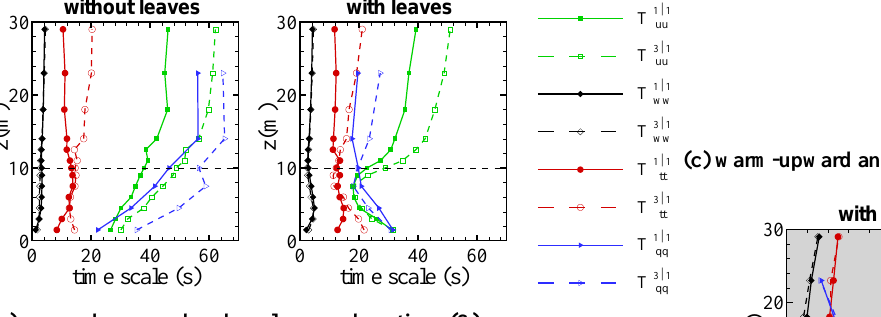
| 1 3 | 1 2 | 1 4 | 1 1 | 1 3 | 1 ϕϕ and T ϕϕ , (b) T ϕϕ and T ϕϕ and (c) T ϕϕ and T ϕϕ in Eq. (11) with z = Z . The dashed line indicates